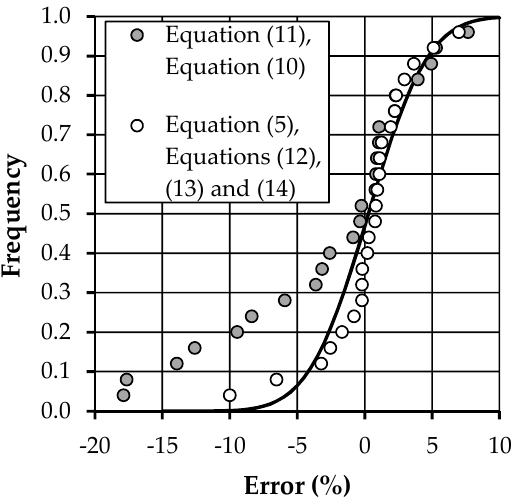
Figure 8. Frequency distribution of the errors obtained applying Equation (5) coupled with Equations (12), (13) and (14), and Equation (11) coupled with Equation (10).